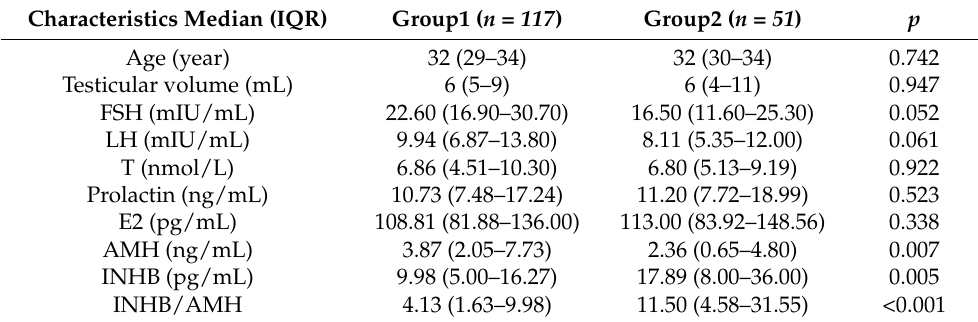
Table 1. Clinical characteristics and hormonal profile stratified by groups. Characteristics Median (IQR) Group1 ( n = 117